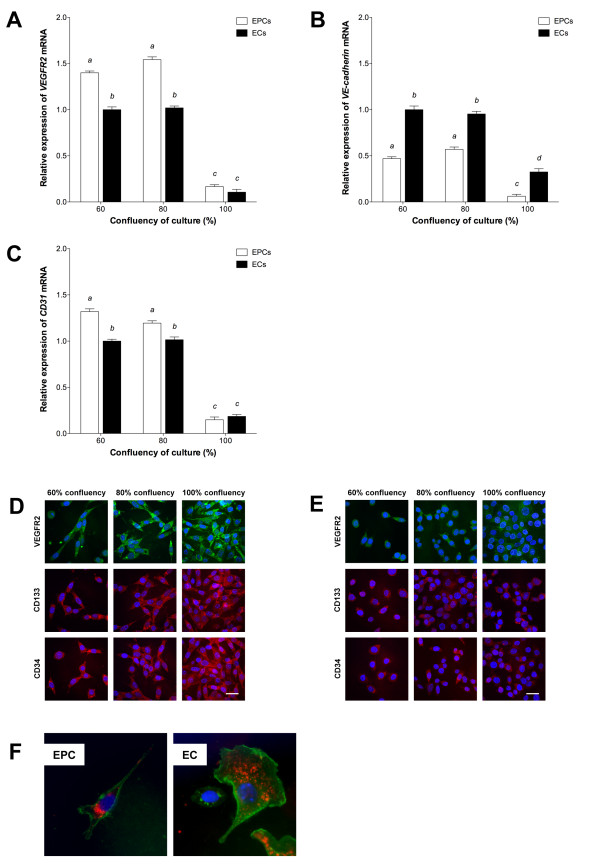
Characterization of EPCs and ECs. qPCR of (A) VEGFR2, (B) VE-cadherin and (C) CD31 expression at increasing confluency, relative to 60% confluent ECs (mean ± SEM; n = 3). Columns with different letters are significantly different (P < 0.05). ICC of VEGFR2, CD133 and CD34 in (D) EPCs and (E) ECs. Scale bar = 30 μm. (F) Uptake of DiI-ac-LDL (red) and staining with lectin (green). Nuclear staining (blue) with DAPI-containing mounting medium.